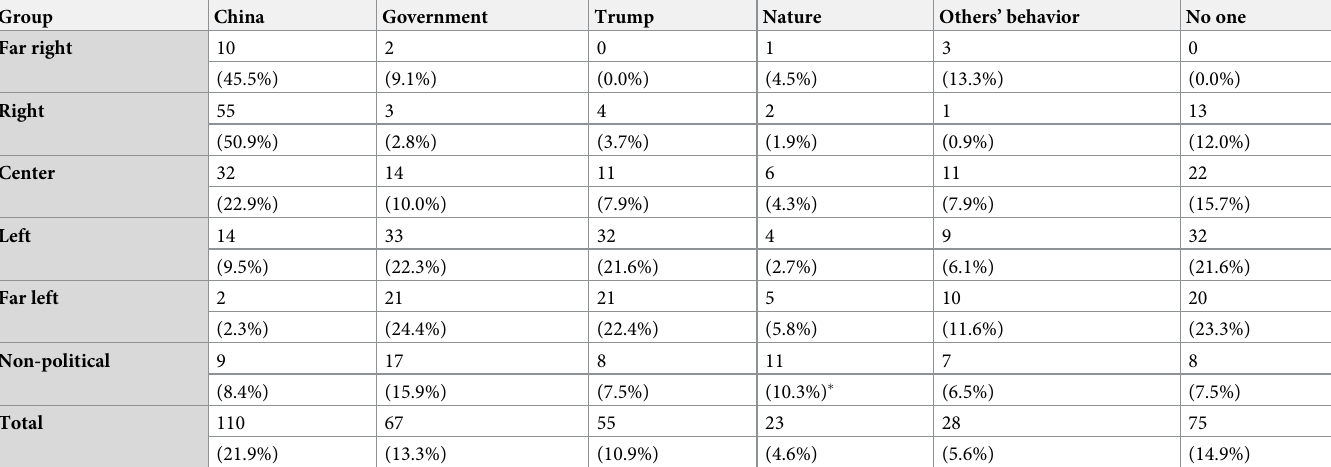
Table 3. Frequencies and percentages for the most common responses to the question “who is to blame for COVID-19?” among voting